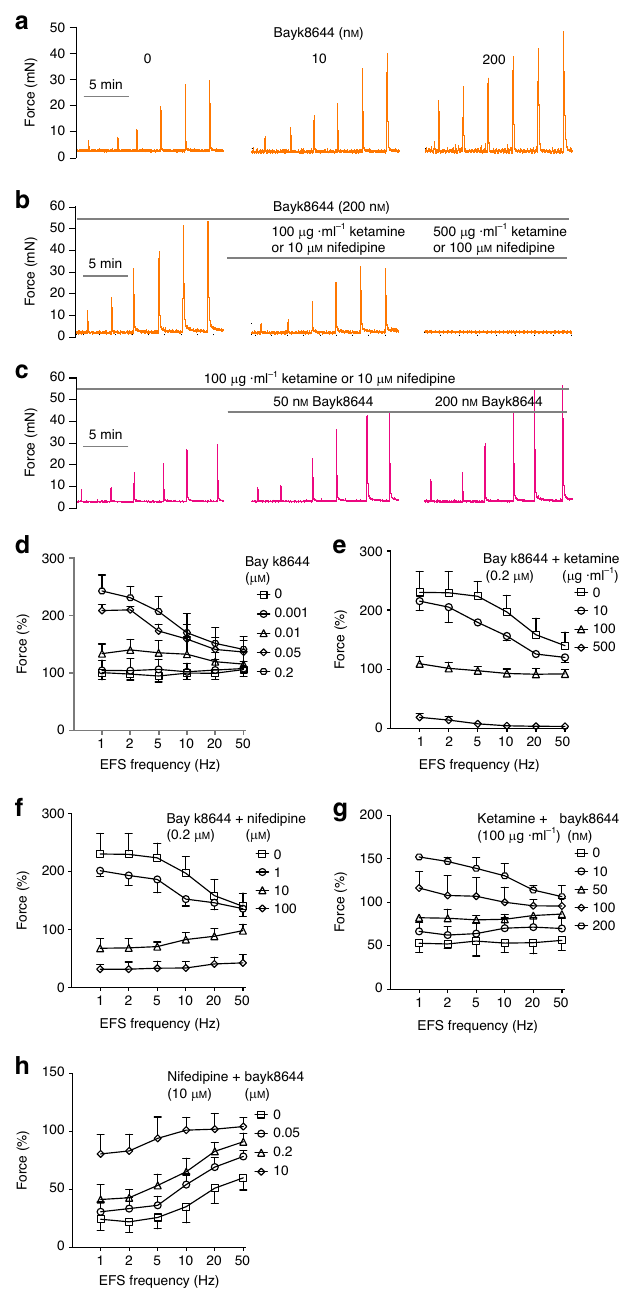
Fig. 3 Ketamine and Cav1.2 agonist Bay k8644 are mutual antagonists. a Representative traces of Bay k8644-mediated potentiation of EFS- stimulated BSM contraction, summarized in d ( n = 7 BSM strips). b Representative traces of Bay k8644-mediated potentiation of EFS- stimulated BSM contraction fully inhibited by ketamine and by nifedipine in dose-dependent manners, summarized in e ( n = 8 BSM strips) and f ( n = 12 BSM strips). c representative traces of ketamine-induced and nifedipine- induced inhibition of EFS-stimulated BSM contraction rescued by 50 or 200 nM Bay k8644, summarized in g ( n = 17 BSM strips) and h ( n = 13 BSM strips). Data are presented as mean values ± SD. These data support ketamine as an inhibitor of Cav1.2-mediated BSM contraction. Source data are provided as a Source Data fi